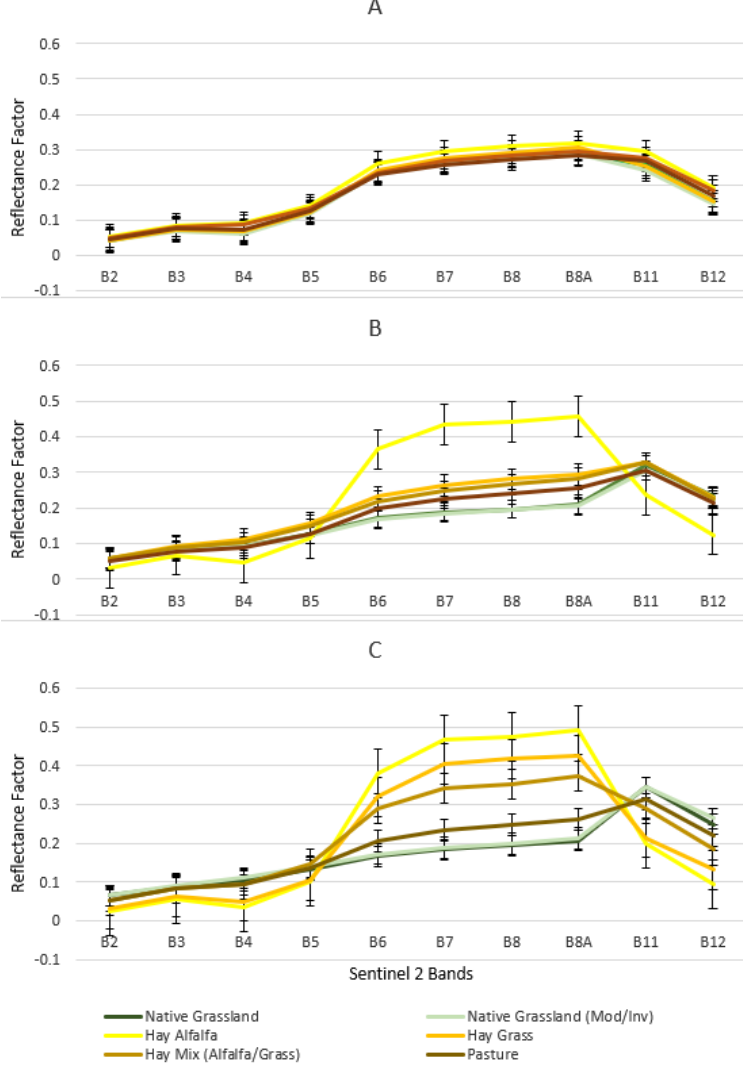
Figure 3. Spectral signature, derived from Sentinel-2 images, for different grass/forage types in three ecoregions: ( A ) Fescue Ecoregion, ( B ) Moist-Mixed Ecoregion, and ( C ) Mixed Ecoregion.